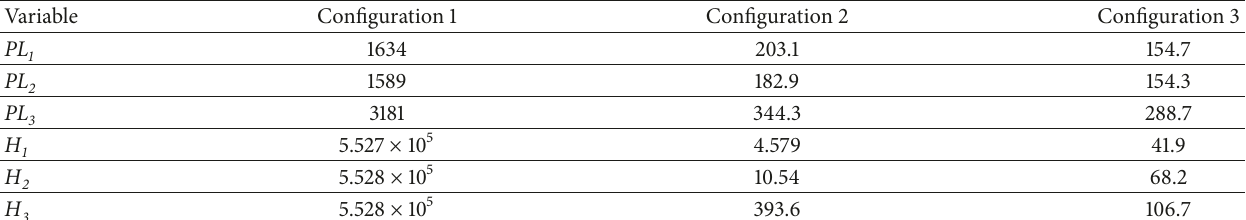
Table 4: IAE performance index